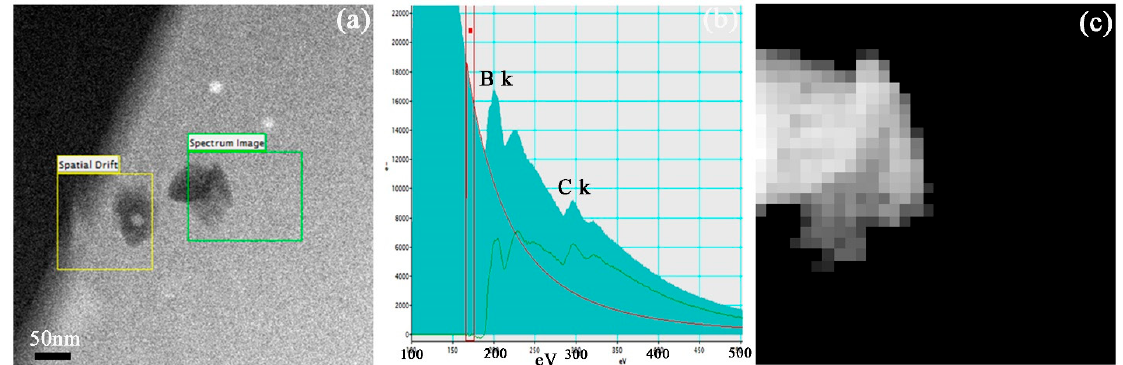
Figure 5. ( a ) HAADF-STEM image showing the morphology of nano-sized B 4 C particles; ( b ) electron energy loss spectroscopy (EELS) spectrum; ( c ) EELS mapping result of boron element in the selected dark particle. dark